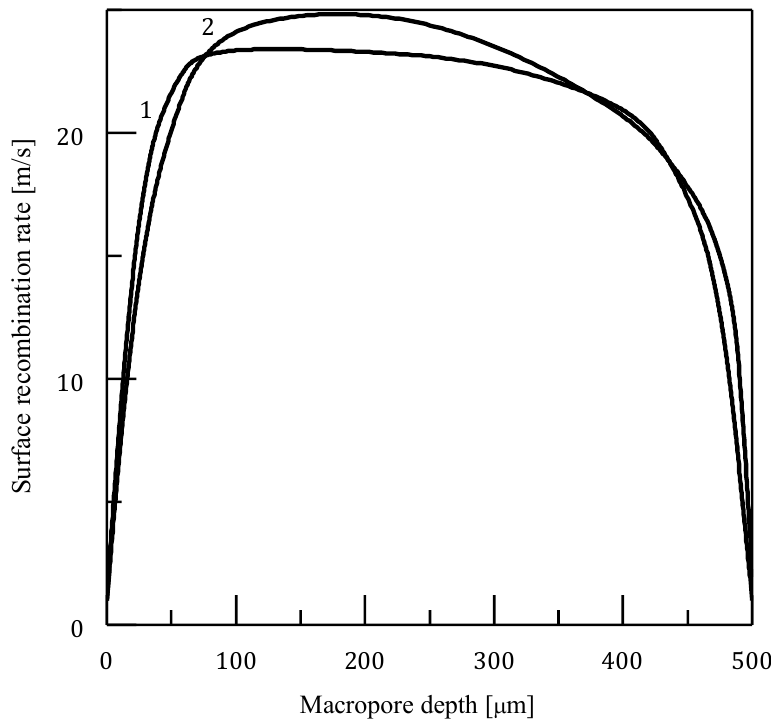
Figure 2. The surface recombination rate on the surface h 1 , calculated by expression (16) - 1, and by expression (18) - 2. The stationary distribution of the excess minority carrier concentration in macroporous silicon δp(x), when illuminated through macropores, was found in Karachevtseva et al. (2017) [12] study. Stationary boundary condition at the surface h 1 is written as